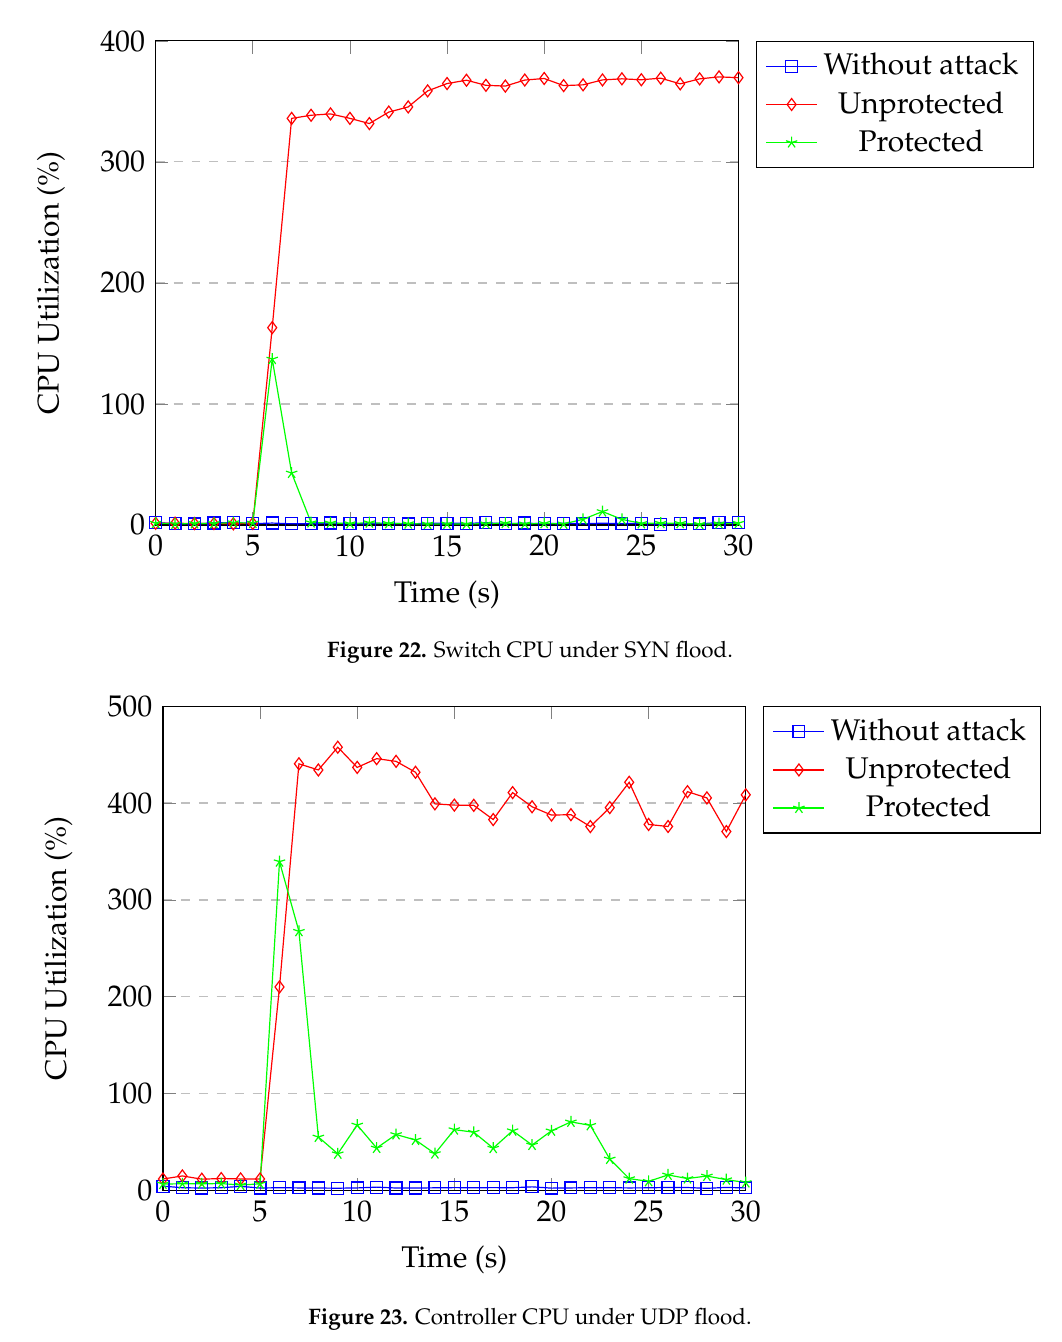
Figure 24. Switch CPU under UDP flood. 7. Conclusion 603